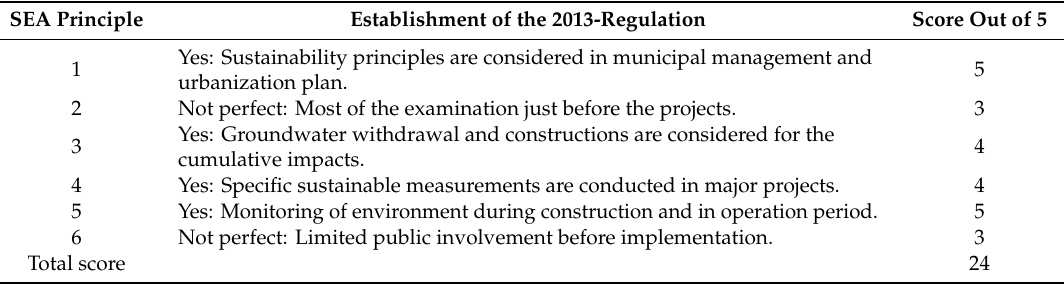
Table 3. Specific evaluation of the 2013-regulation by SEA six principles.